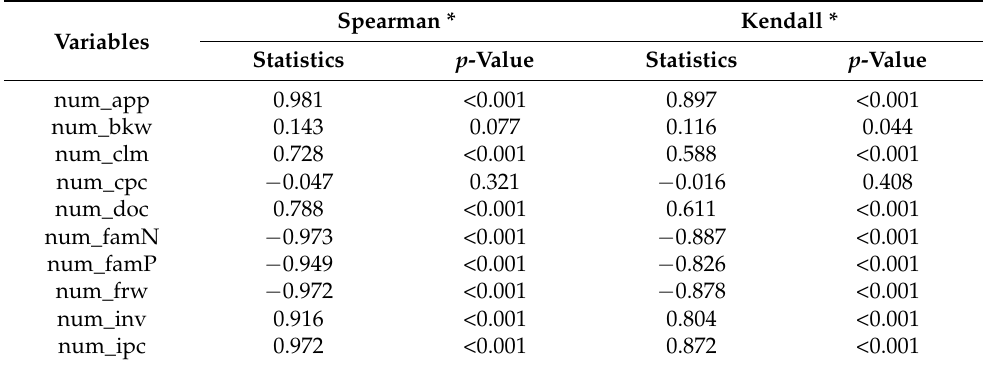
Table 7. Results of statistical tests on factor ablation trials.